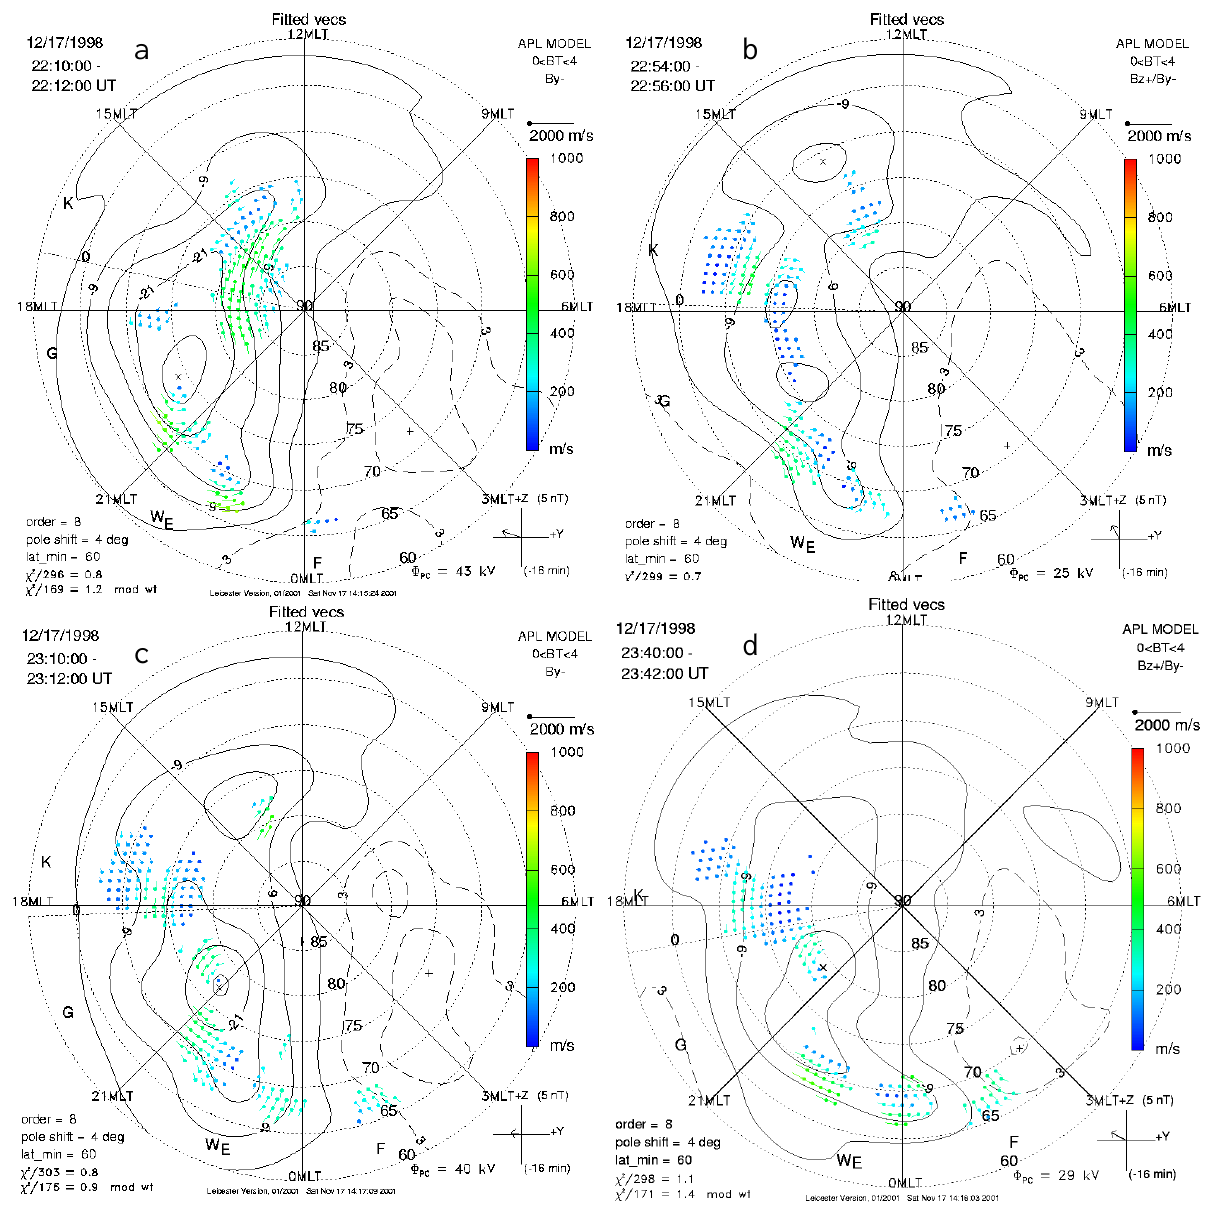
Fig. 8. Fitted velocity vectors and electrostatic potential contours from the line of sight measurements of Northern Hemisphere SuperDARN radars at four selected times during and outside the flow burst events described in Figs. 6 and 7. The direction of the IMF and the cross polar cap potential are indicated on the lower right-hand side of the